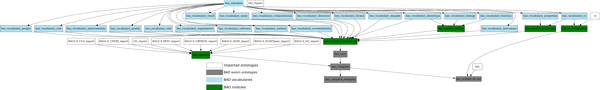
BAO 2.0 ontology modularization framework implementation. BAO 2.0 modularization framework provides effective software engineering methods to build complex ontologies. Shown are the current vocabularies, modules, and axiom files also indicating internal vs. external sources.